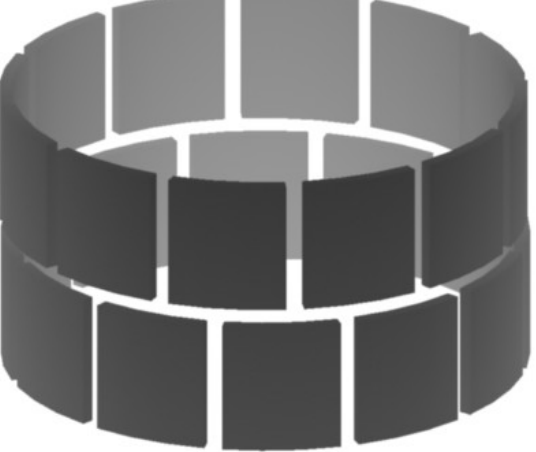
Figure 2. Two-layer ECT sensor